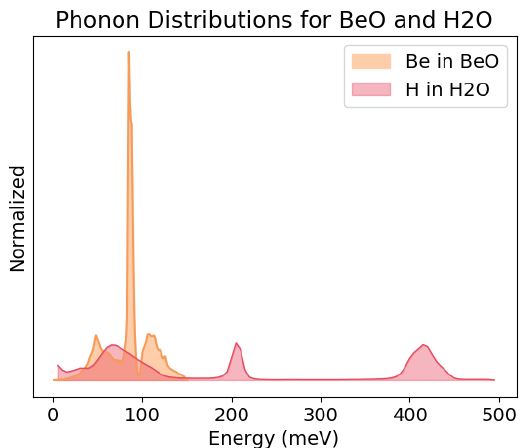
Figure 4: Phonon distributions for H